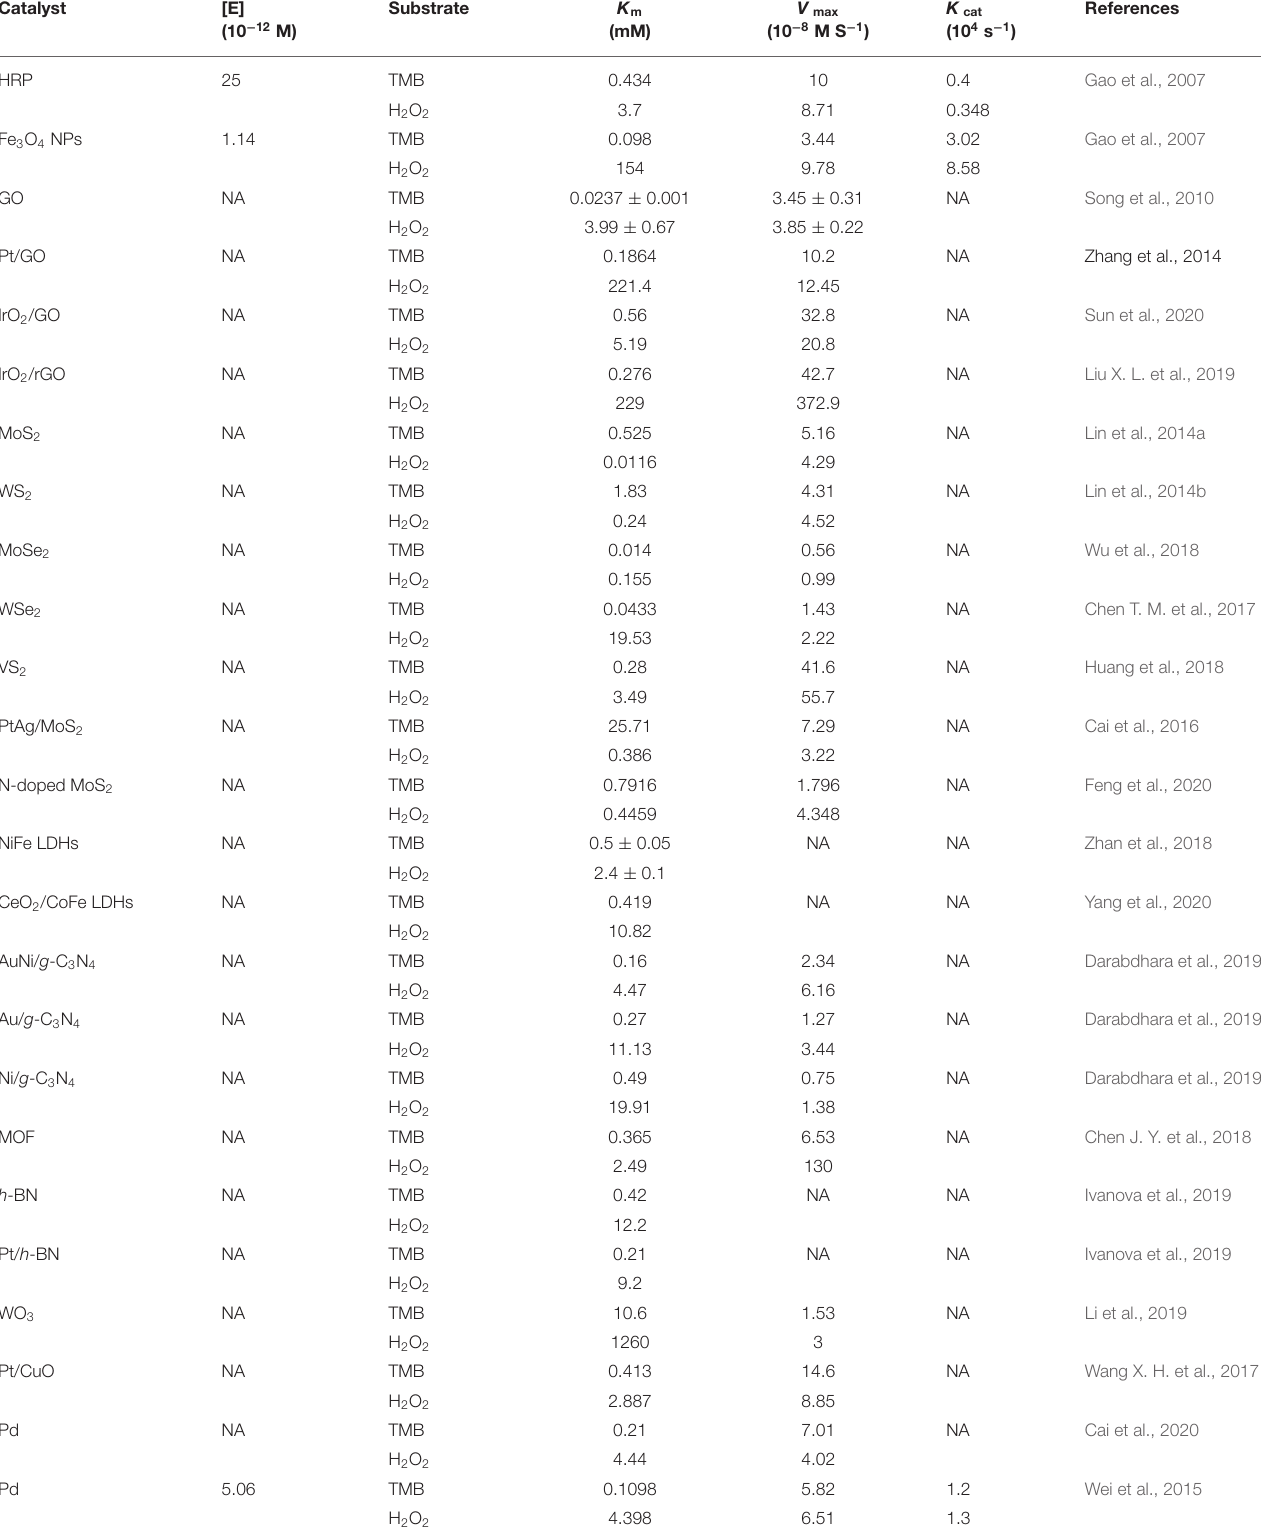
TABLE 1 | The kinetics parameters of HRP, Fe 3 O 4 NPs, and typical 2D POD-mimics a .